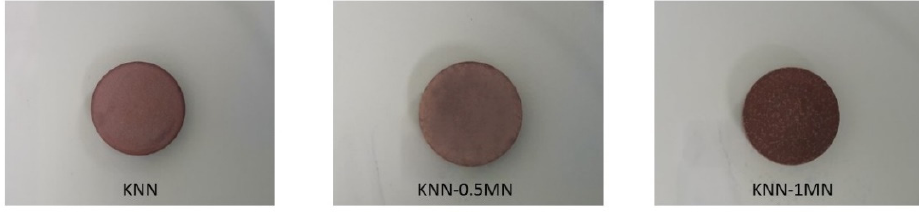
Figure 7. Pictures of KNN-xMN sintered pellets.